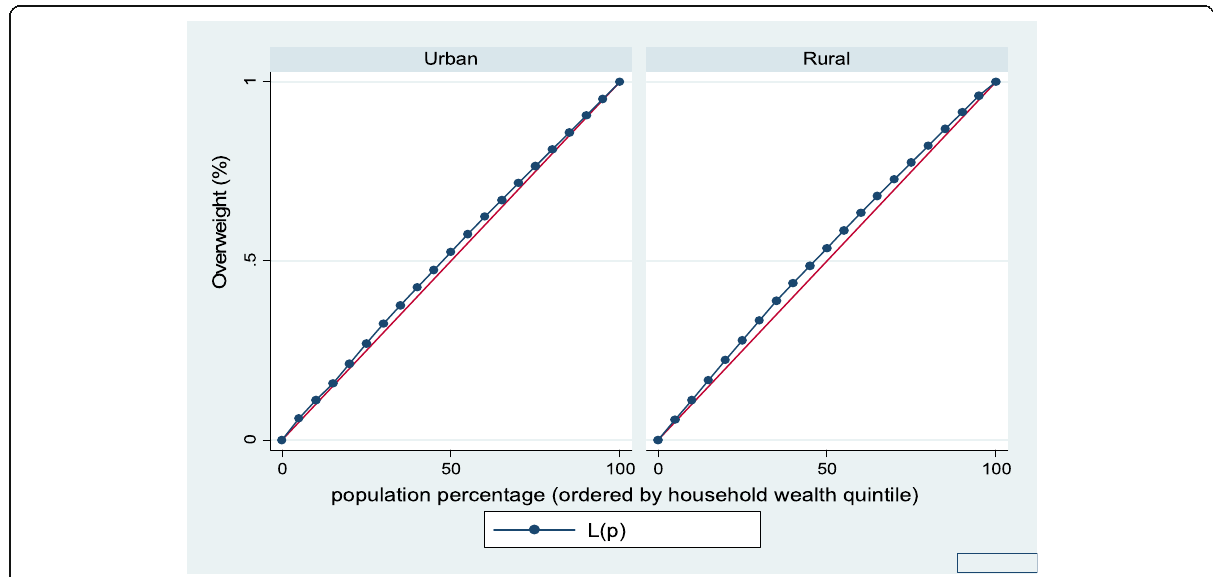
Fig. 4 Urban-rural Lorenz curve for